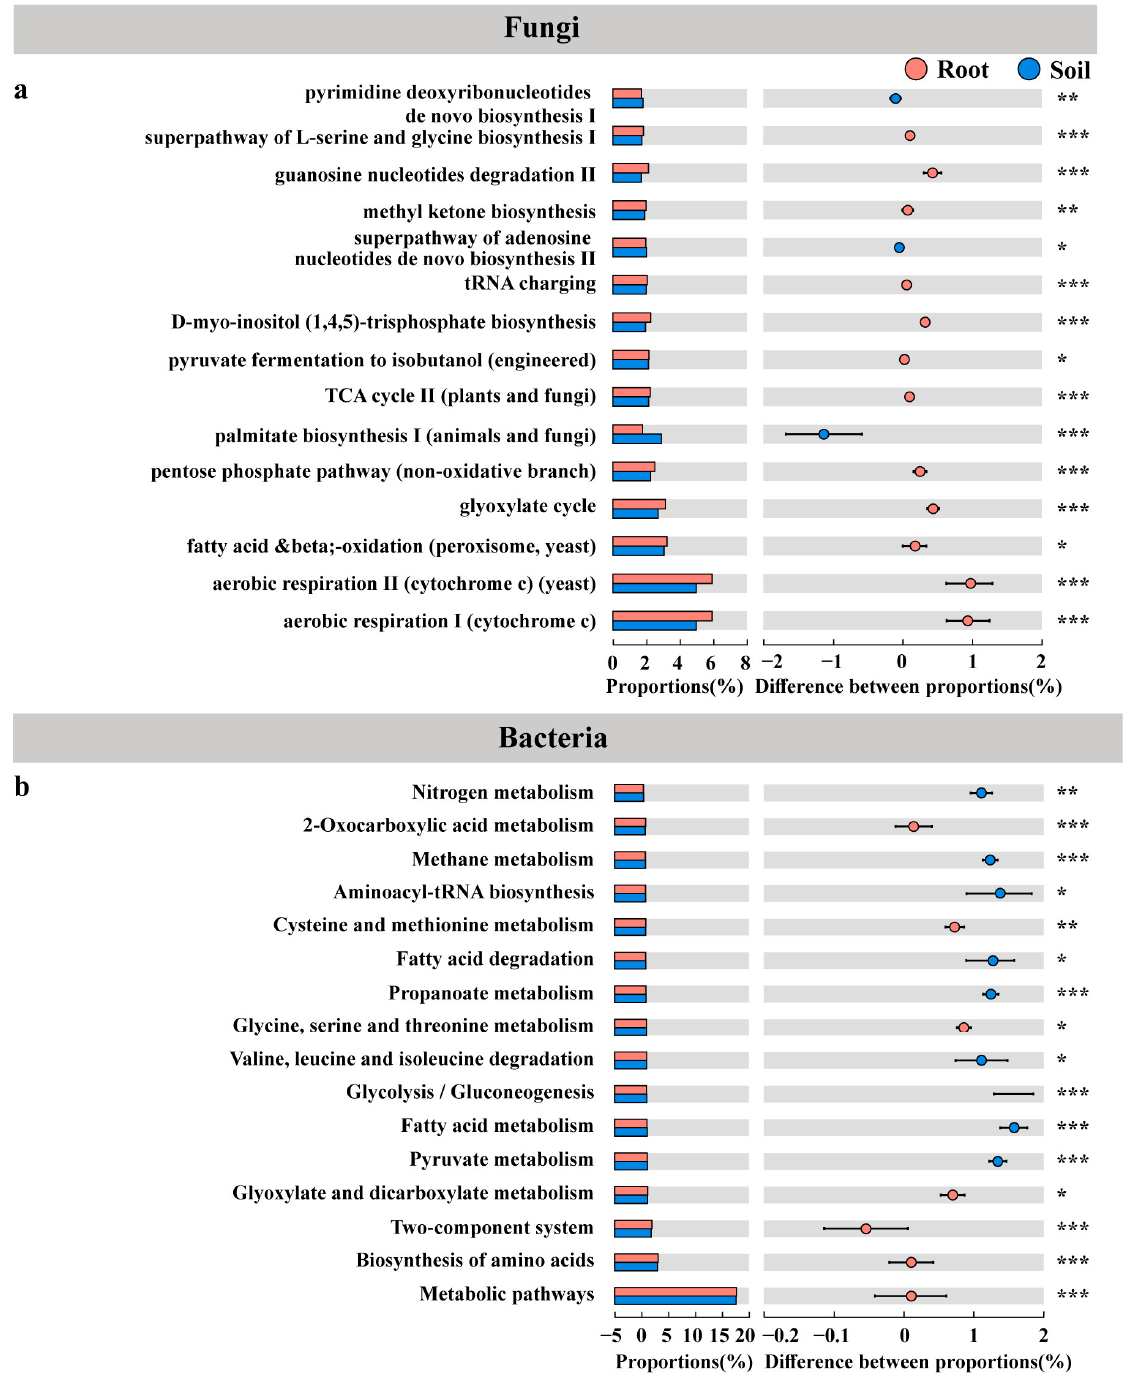
Figure 9. Differentiation of predicted KEGG or MetaCyc functions predicted by PICRUSt2 in rhizo- sphere soil and roots. The different fungal ( a ) and bacterial ( b ) functions between rhizosphere soil and roots predicted by PICRUSt2. Mann–Whitney U tests were used to evaluate differences in the abundance of rhizosphere soil and roots. Significant difference: * p ≤ 0.05, ** p ≤ 0.01, *** p ≤ 0.001.